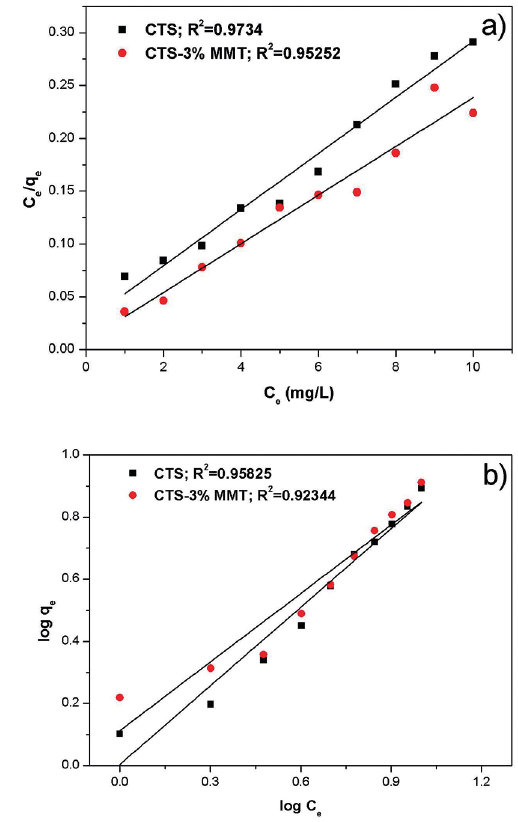
Figure 7: Isotherm plot for the adsorption of CTS and CTS- 3%MMT composite beads; a) The Langmuir adsorption model and b) Freundlich adsorption model where the line were the best fit linear regression